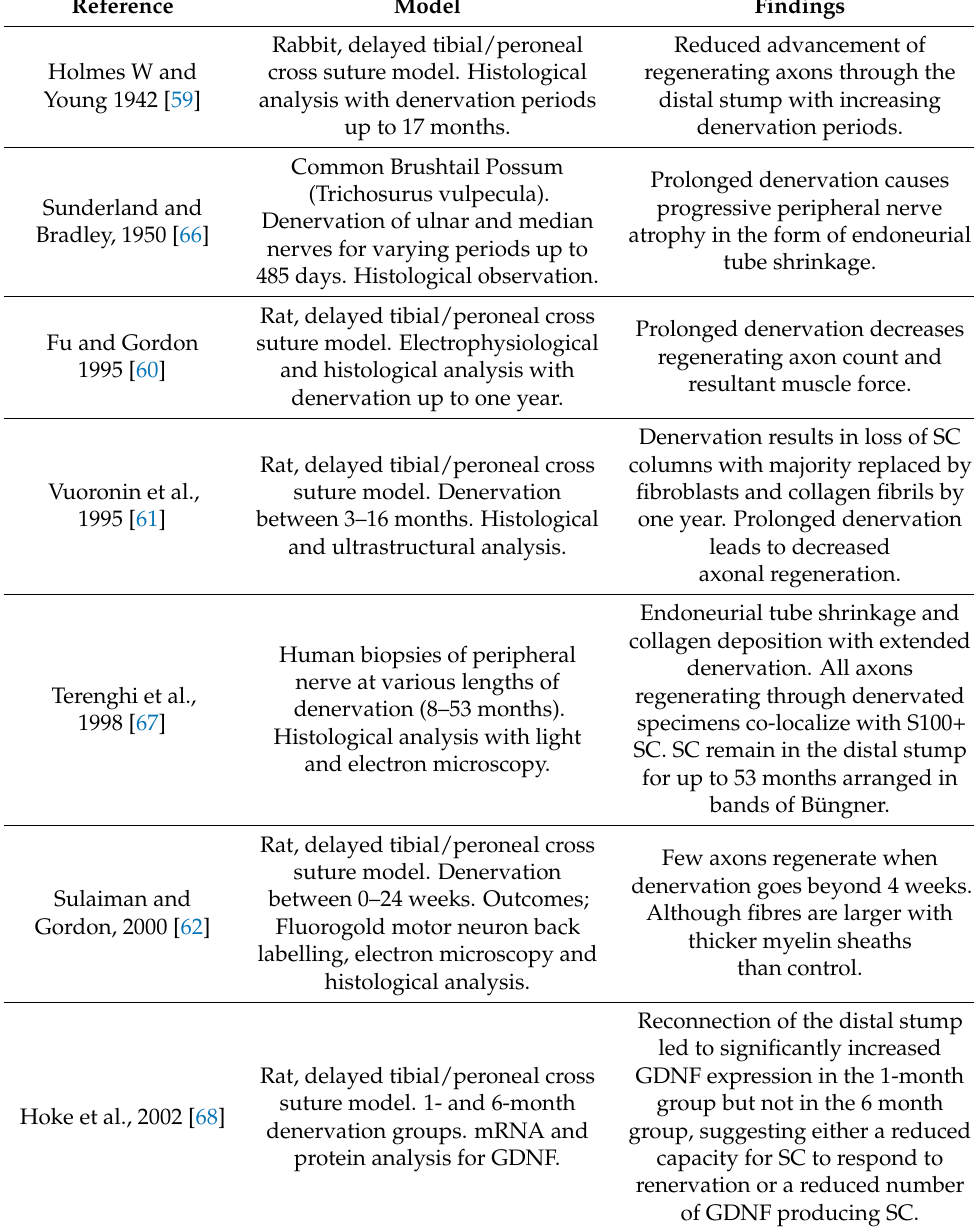
Table 1. Summary of key papers exploring the effects of chronic denervation on peripheral nerve regeneration over the last 80